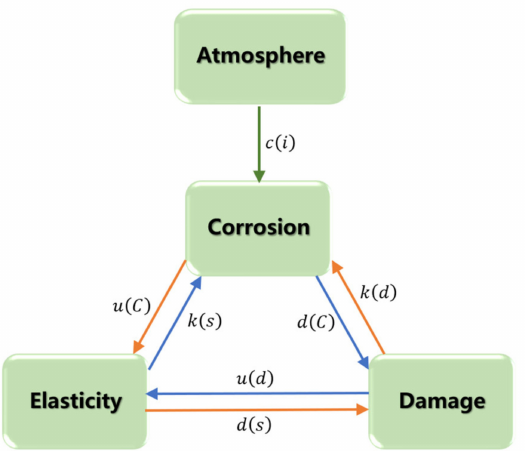
Figure 3. Schematic of the coupled peridynamic atmosphere corrosion–fracture